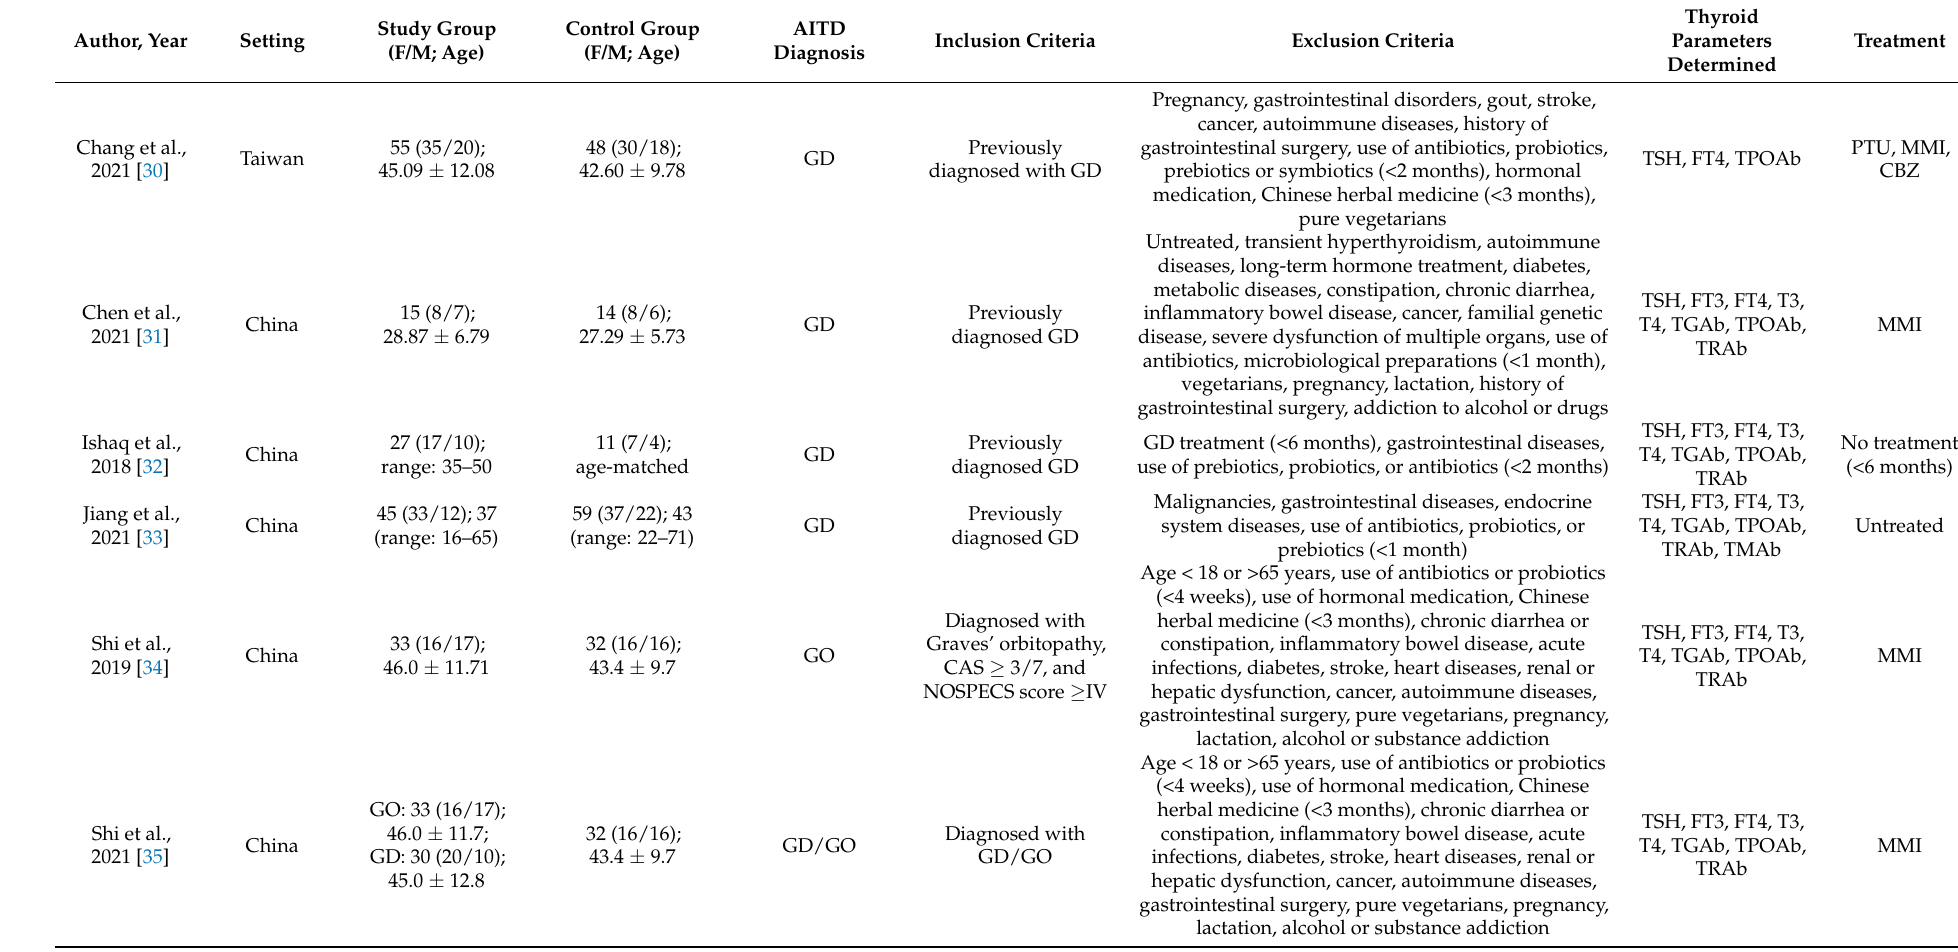
Table 1. General characteristics of the included